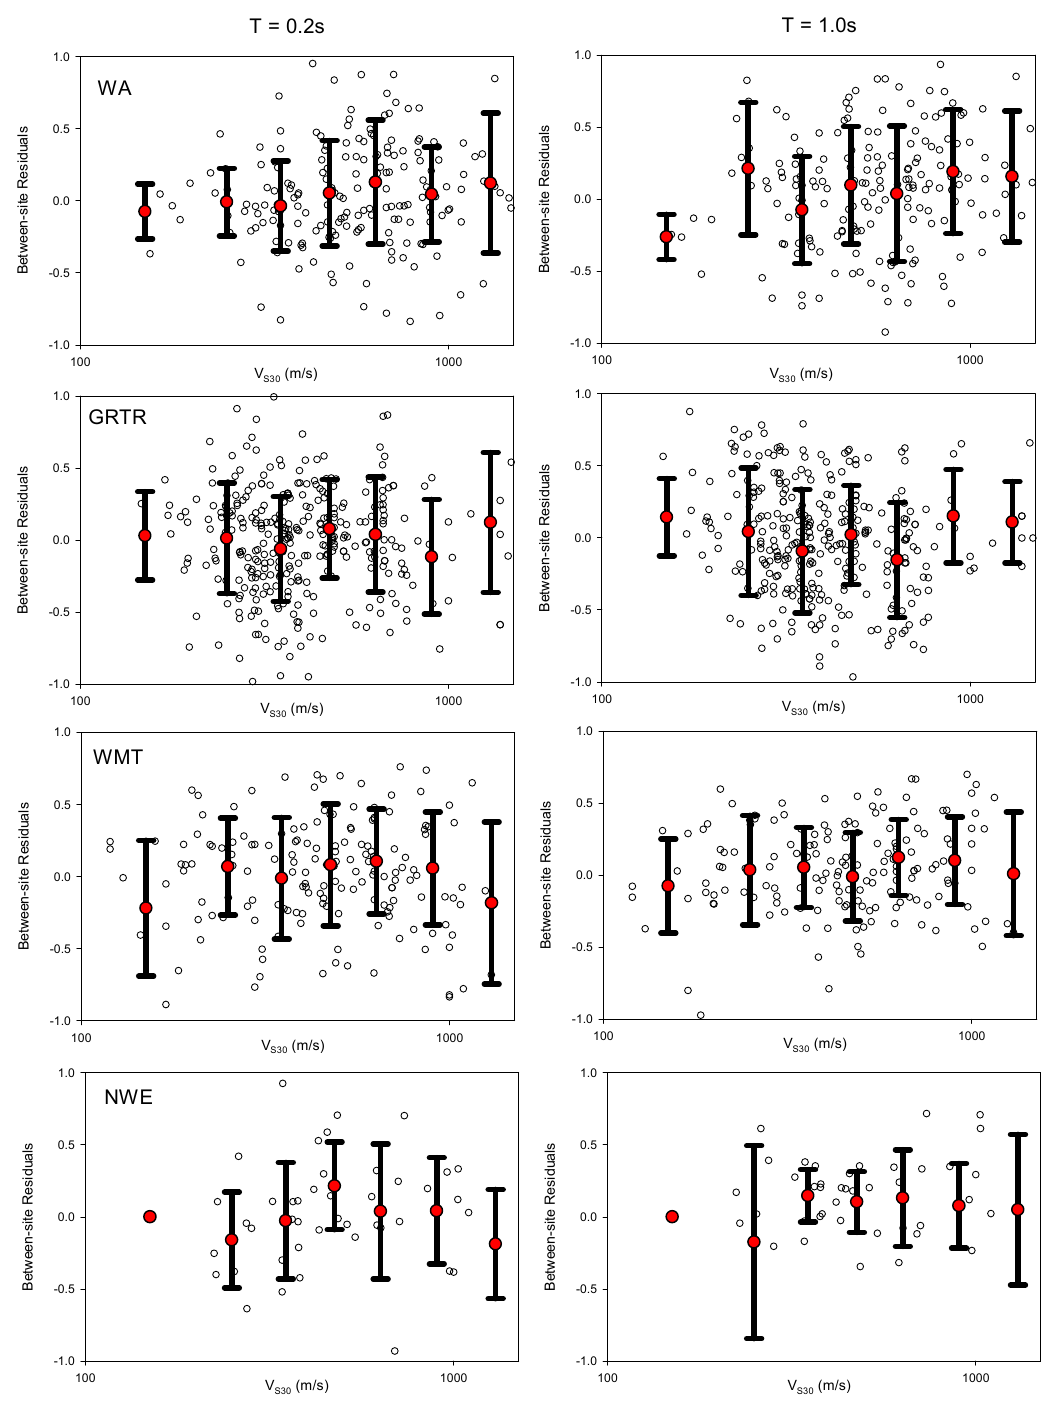
Figure 9. Between-site residuals at T = 0.2 s and 1 s for each region. The variability of site amplification (computed by observed PSA value divided by estimated PSA rock and between-event residuals) for each region is plotted for V S 30 (left panel) and PSA rock (right panel) bins for T = 0.2 s (top row) and T = 1.0 s (bottom row) in Figure 10. The intervals of V S 30 and PSA rock are given in the figure caption. The regional variability also had a wide range for both V S 30 and PSA rock bins. For example, soft-soil site standard deviation was 0.2 and 0.55 for the TW region and JP region, respectively. Rock-site standard deviation was generally lower than very stiff site sigma. There is a decreasing trend from very stiff sites to very soft sites. However, for some regions this observation did not hold, with larger variability being computed at very soft sites. The similar